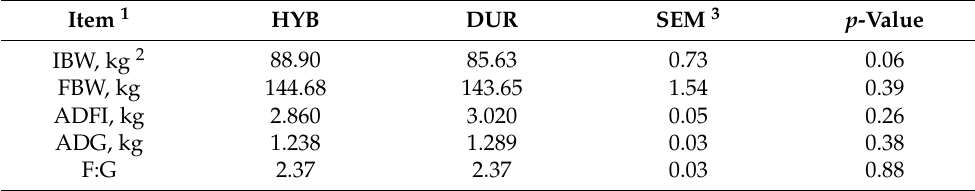
Table 4. Performance of pigs of different genetic lines.